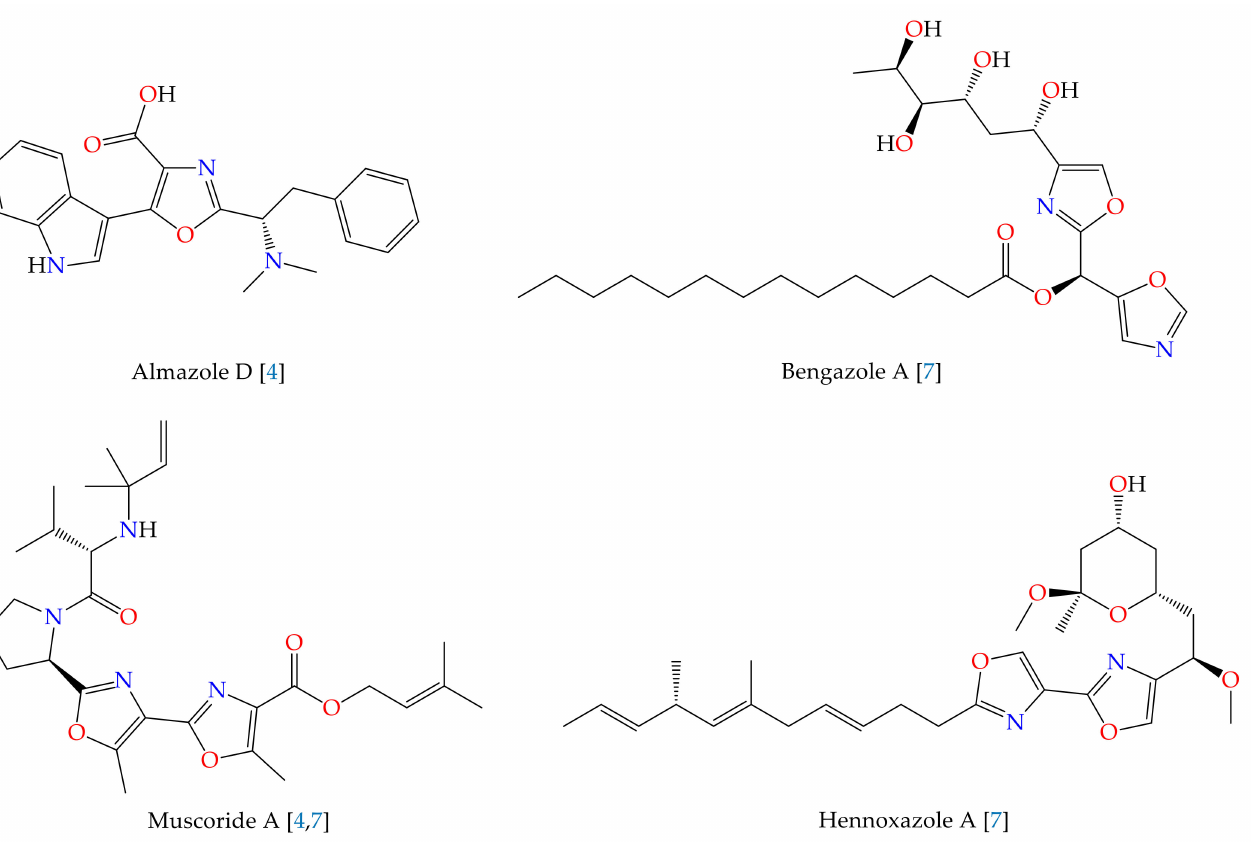
Figure 1. Structures of some representative bioactive naturally occurring compounds containing 1,3-oxazole